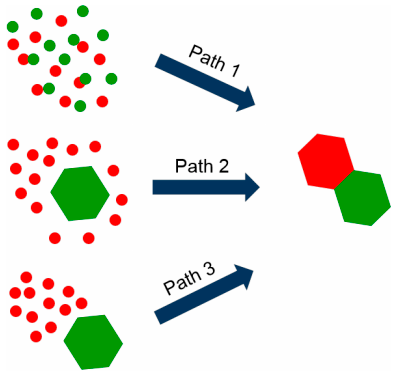
Scheme 5. Possible formation paths of